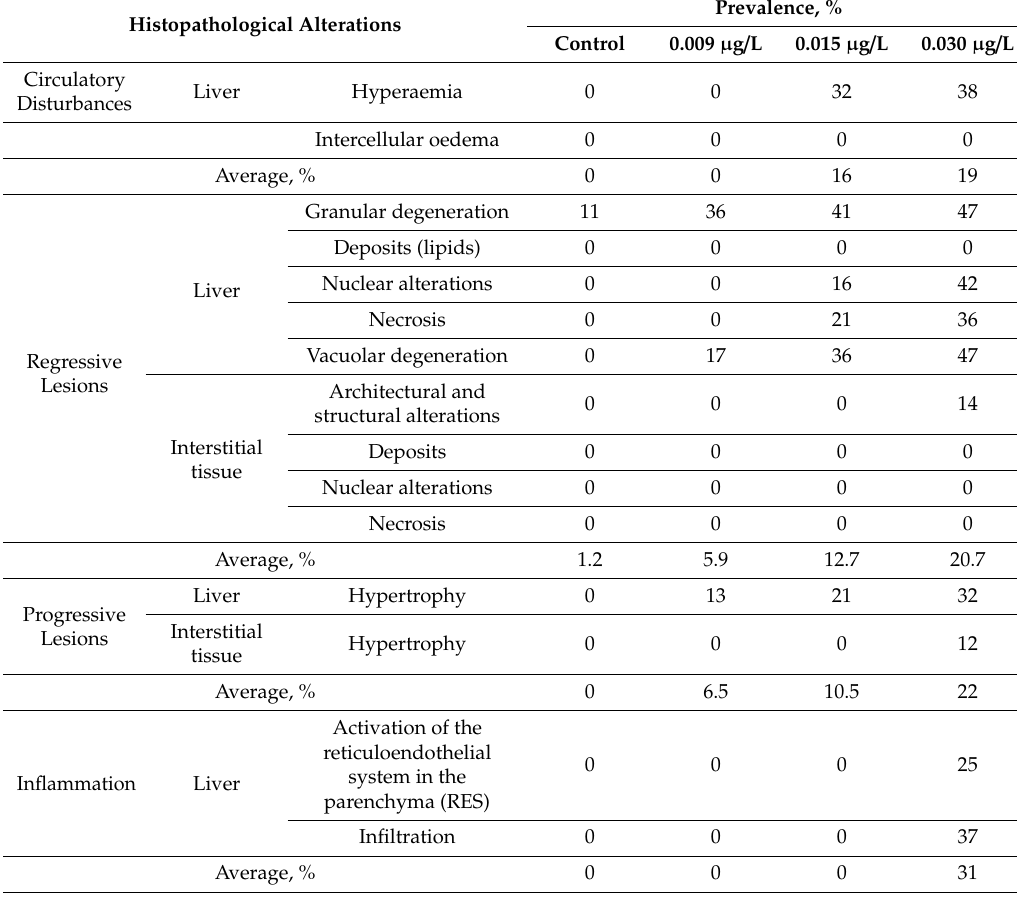
Table 3. Percentage of histopathological alterations in common carp liver after the exposure with decreasing CPF concentrations based on Directive 2013 / 39 / EU of the European Parliament and of the